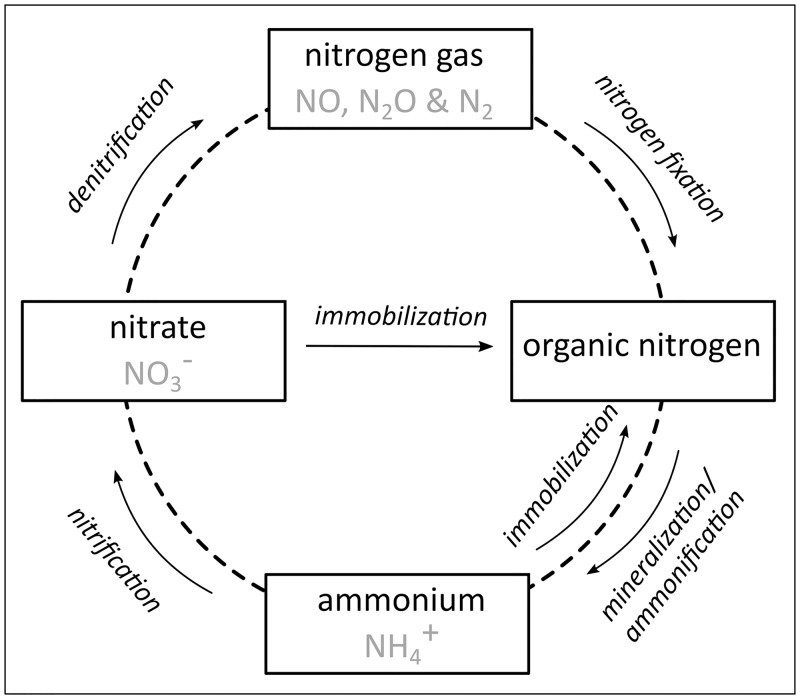
Simplified nitrogen cycle (after [64]).